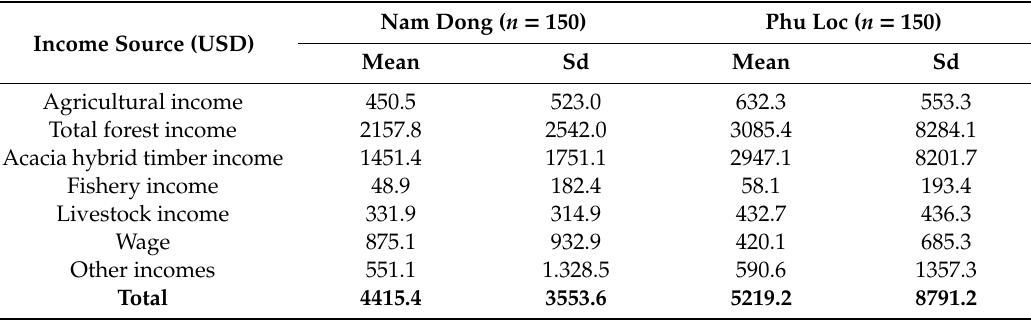
Table 6. Income portfolio by each income source in Nam Dong and Phu Loc